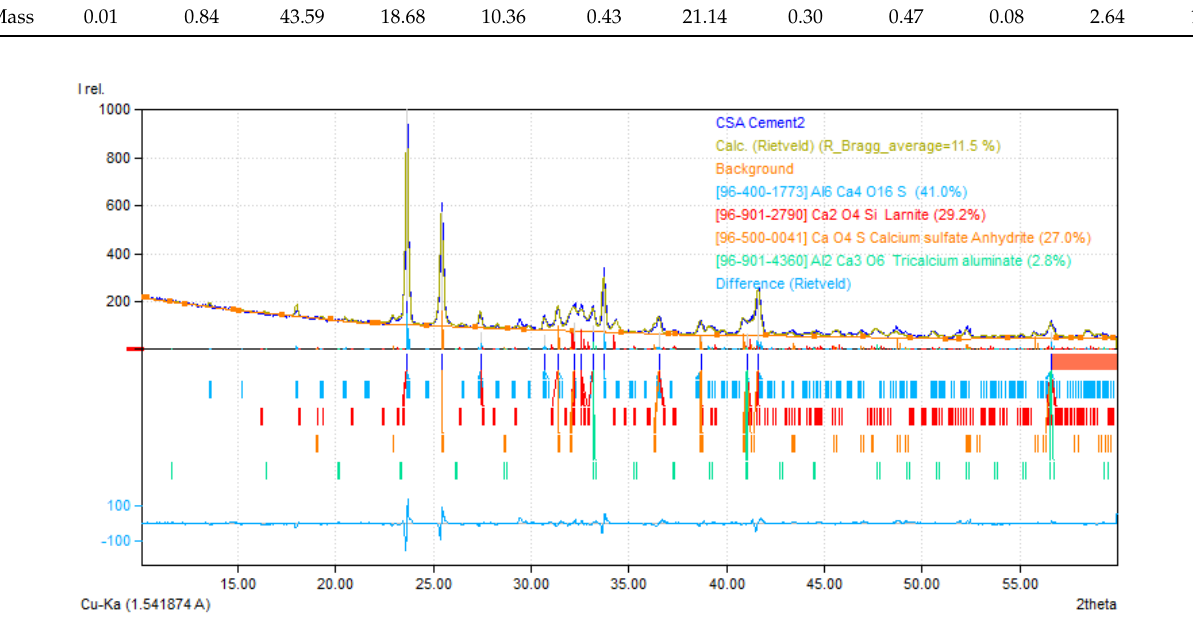
Figure 1. Rietveld refinement of the X-ray powder diffraction pattern of the CSA cement, showing percentages of the constituent minerals. The reference patterns for the identified phases, ye’elimite [39], belite (larnite [40]), anhydrite [41], and aluminate [42], are from the Crystallography Open Database (COD).